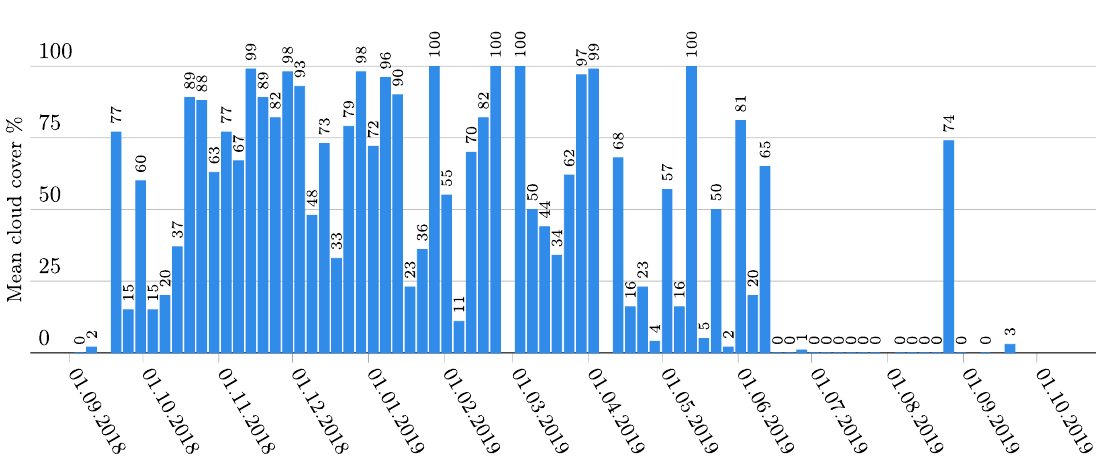
Figure 2. Evolution of the cloud cover percentage over the SSIL between 05.09.18 and 20.09.19 according to the metadata of the Sentinel-2 product.